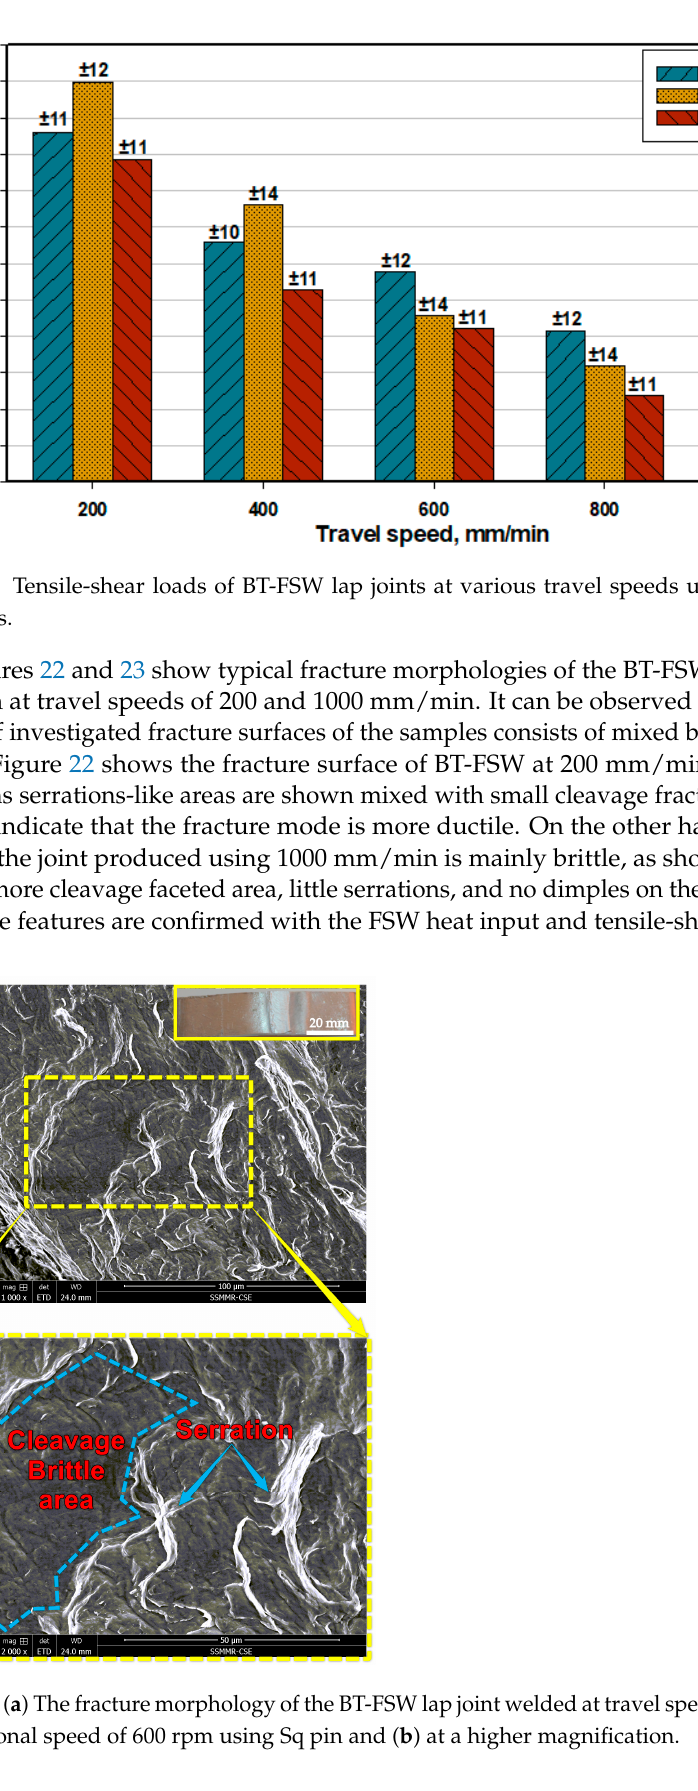
Figure 23. ( a ) The fracture morphology of the BT-FSW lap joint welded at a travel speed of 1000 mm/min and rotational speed of 600 rpm using Sq pin and ( b ) at a higher magnification.